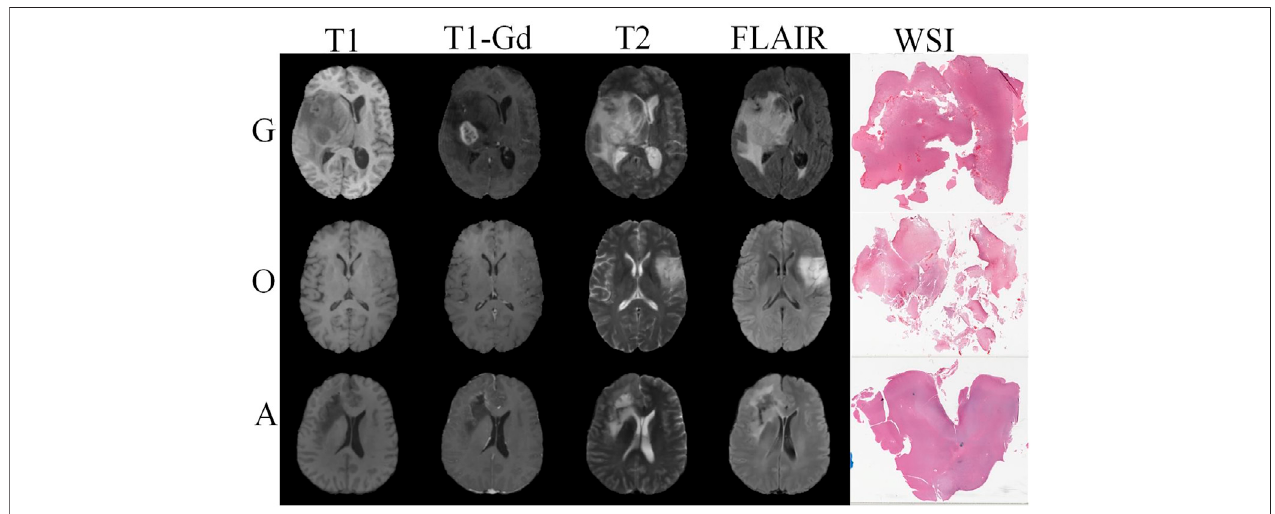
FIGURE 1 | Visualization of glioblastoma (G), oligodendroglioma (O), and astrocytoma (A) in four sequences of MRI images and paired pathology